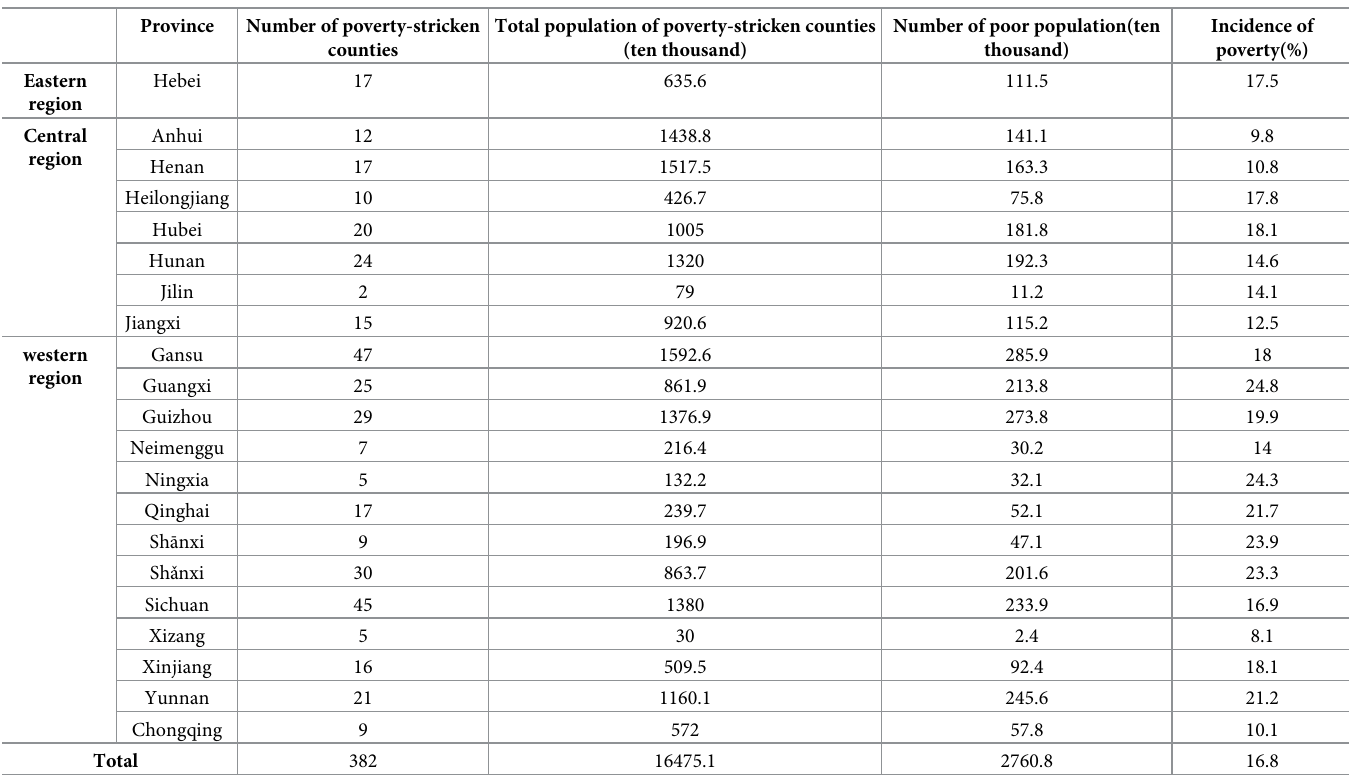
Table 1. Distribution of 382 poverty-stricken counties.